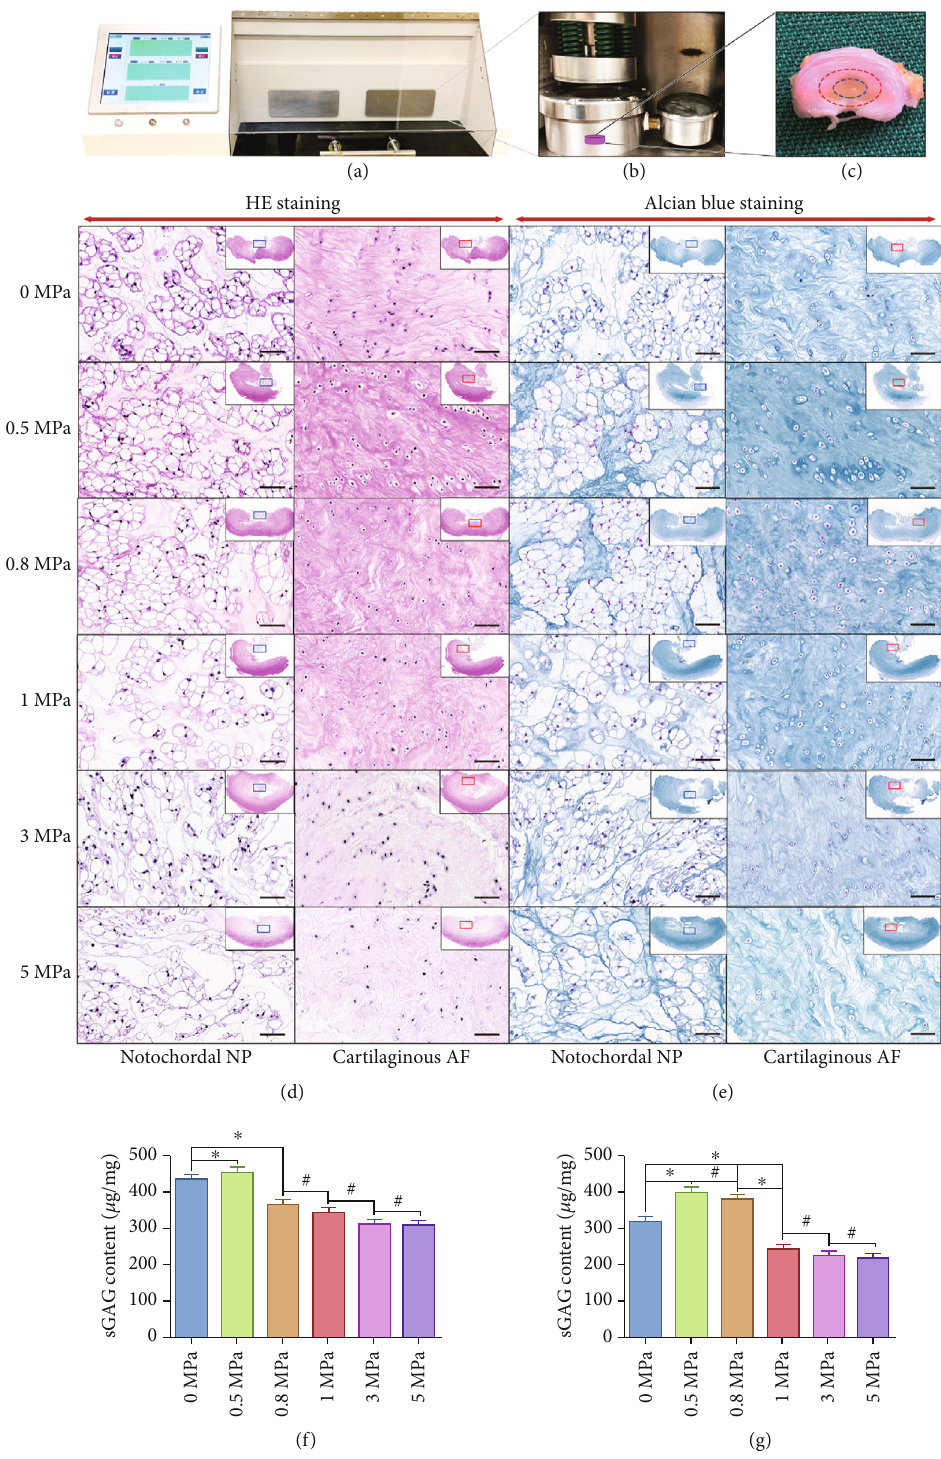
Figure 1: E ff ect of hydrostatic pressure on histomorphology and glycosaminoglycan synthesis of the rabbit notochordal NP and fi brocartilaginous inner AF: (a) appearance of the self-developed hydrostatic pressure bioreactor and touch-screen control system; (b) appearance of the tissue culture chamber of hydrostatic pressure bioreactor; (c) gross view of the endplate-removed rabbit IVD: the area in the blue circle indicates the notochordal NP, and the area between the red and blue circles indicates the fi brocartilaginous inner AF; (d) HE staining of the notochordal NP and fi brocartilaginous inner AF under graded hydrostatic pressure (200x); (e) alcian blue staining of the notochordal NP and fi brocartilaginous inner AF under graded hydrostatic pressure (200x); (f) quanti fi cation of the notochordal NP sGAG under graded hydrostatic pressure; (g) quanti fi cation of the fi brocartilaginous inner AF sGAG under graded hydrostatic pressure. ∗ P < 0 : 05 . # P > 0 : 05 . Scale bar = 100 μ